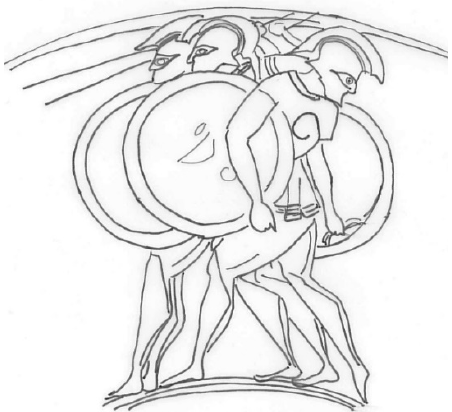
Figure 6. Black-figured cup (ca. 550–530 BCE), Rome, Museo Nazionale di Villa Giulia 1225 (CVA, Rome Museo Nazionale di Villa Giulia 3, III H. E. 18, Pls. 29.2–5, 30.1–2). Drawing by the author.